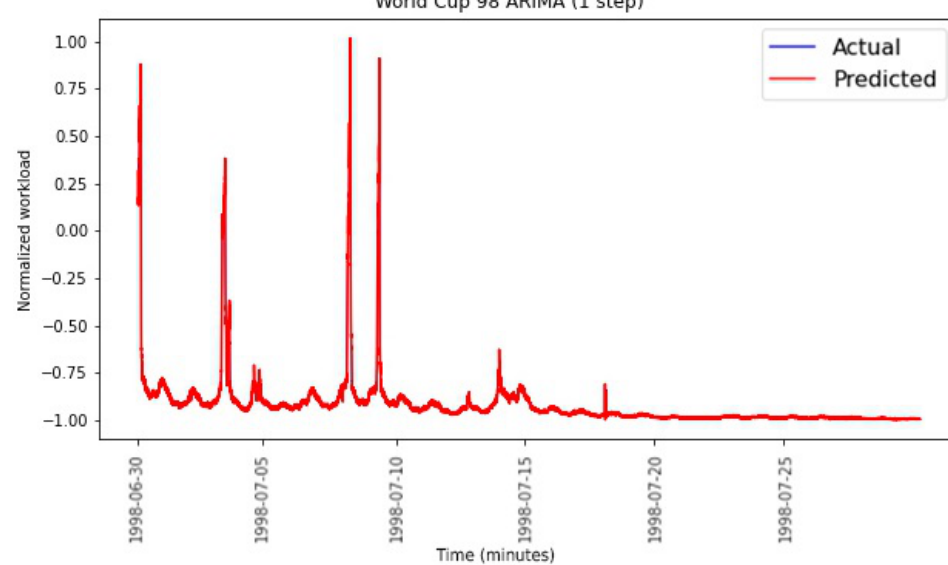
Figure 10. ARIMA with one-step prediction on the testing